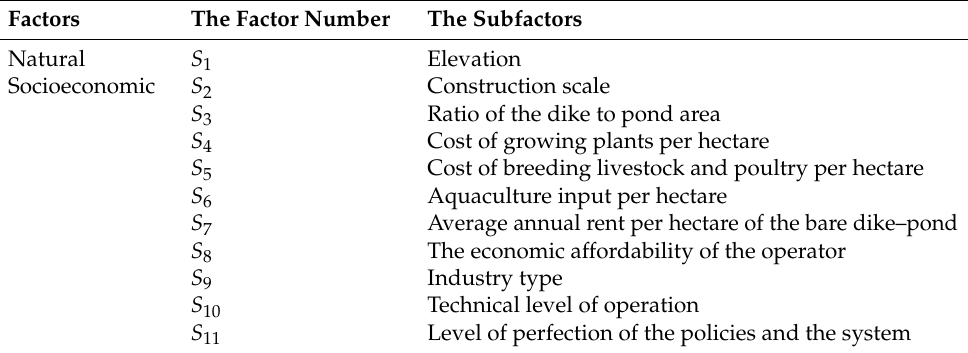
Table 1. Main controlling factors of the land-use modes of the dike–pond